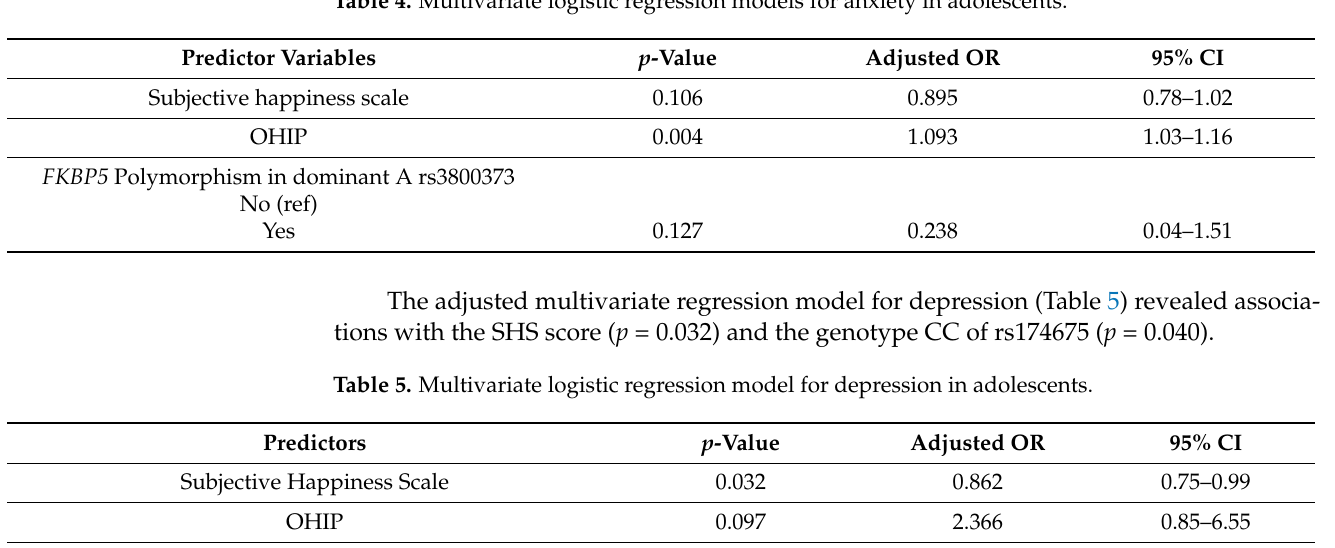
tion with negative impact on OHRQoL ( p = 0.004). Table 4. Multivariate logistic regression models for anxiety in adolescents.